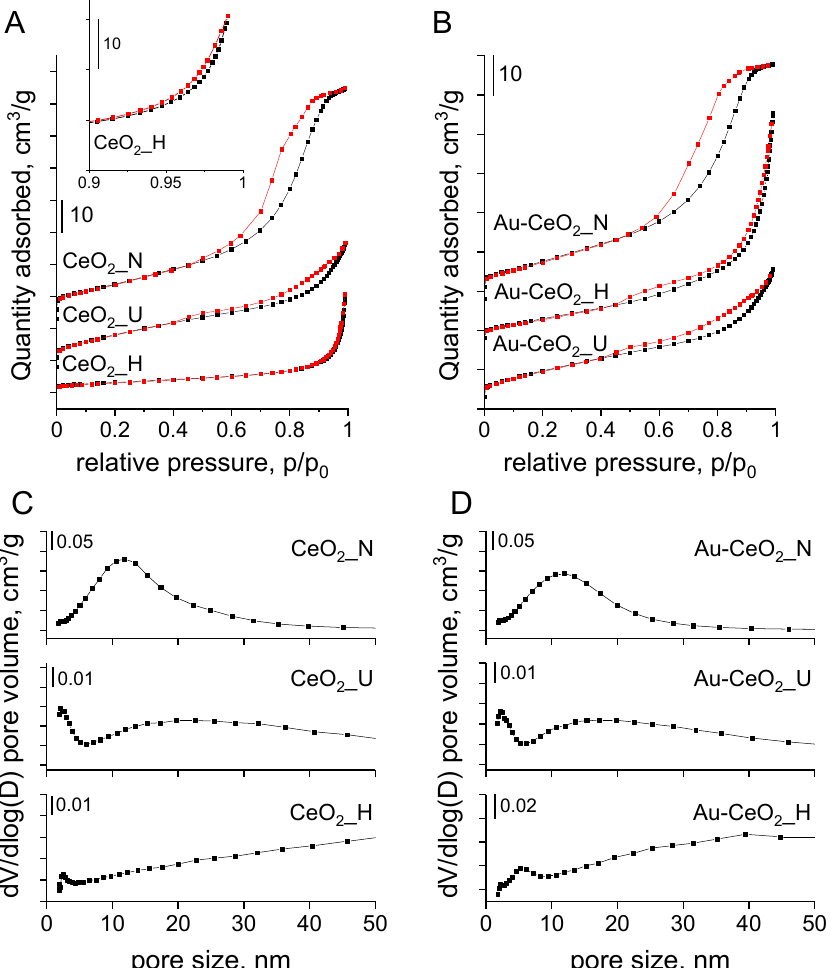
Figure 2. Nitrogen adsorption–desorption isotherms ( A , B ) and pore size distribution ( C , D ) esti- mated for CeO 2 and Au-CeO 2 catalysts. for CeO 2 and Au-CeO 2